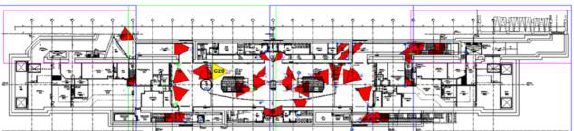
Figure 2 The CCTV coverage in a 2D floor plan